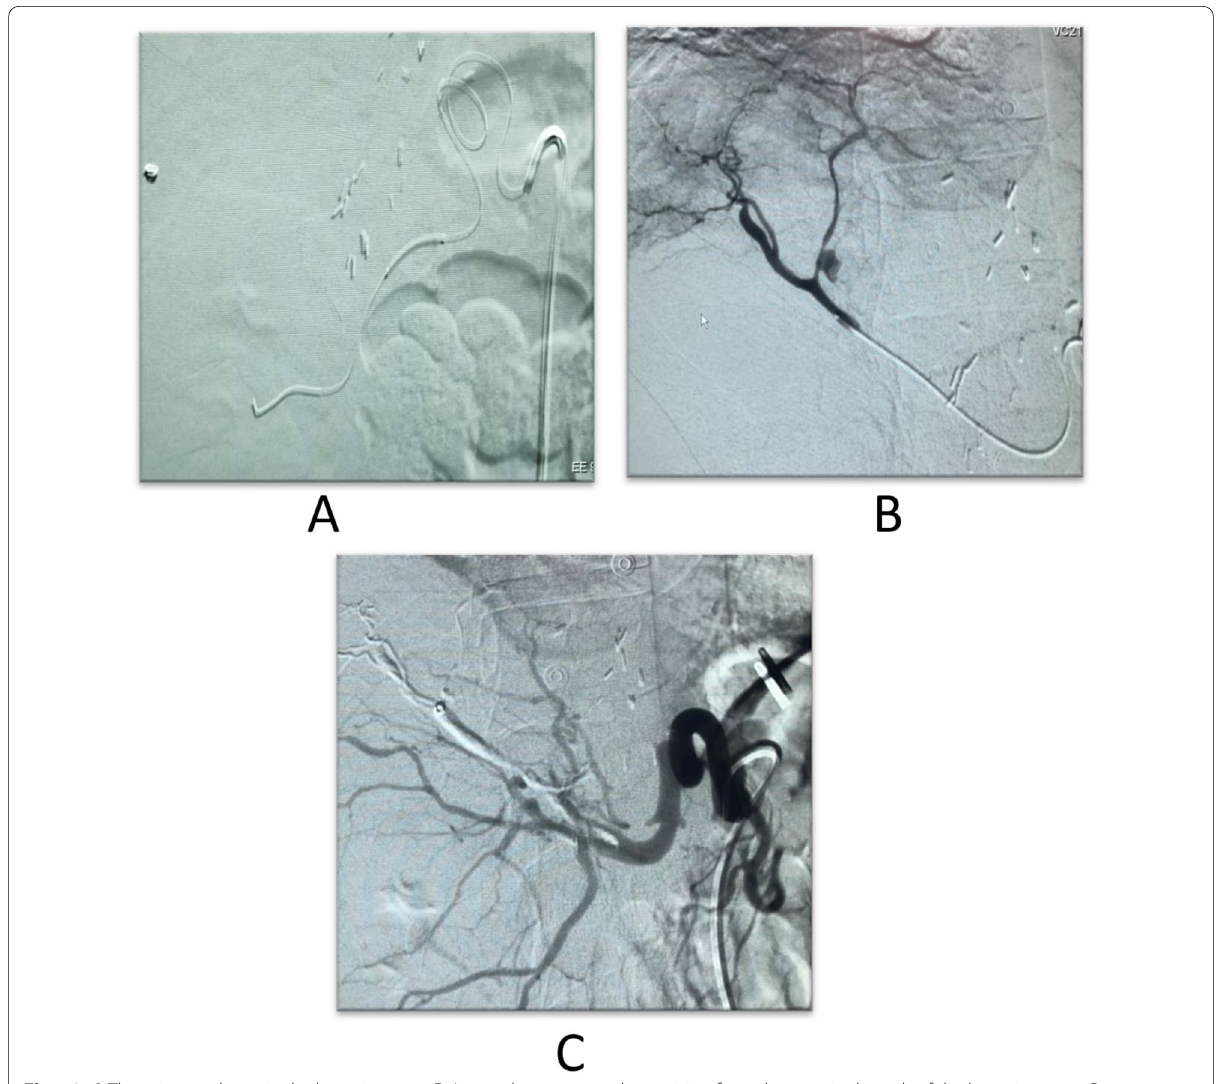
Fig. 10 A The micro‑catheter in the hepatic artery. B A pseudo‑aneurysmal sac arising from the anterior branch of the hepatic artery. C Non‑opacification of the pseudo‑aneurysmal sac after histoacryl